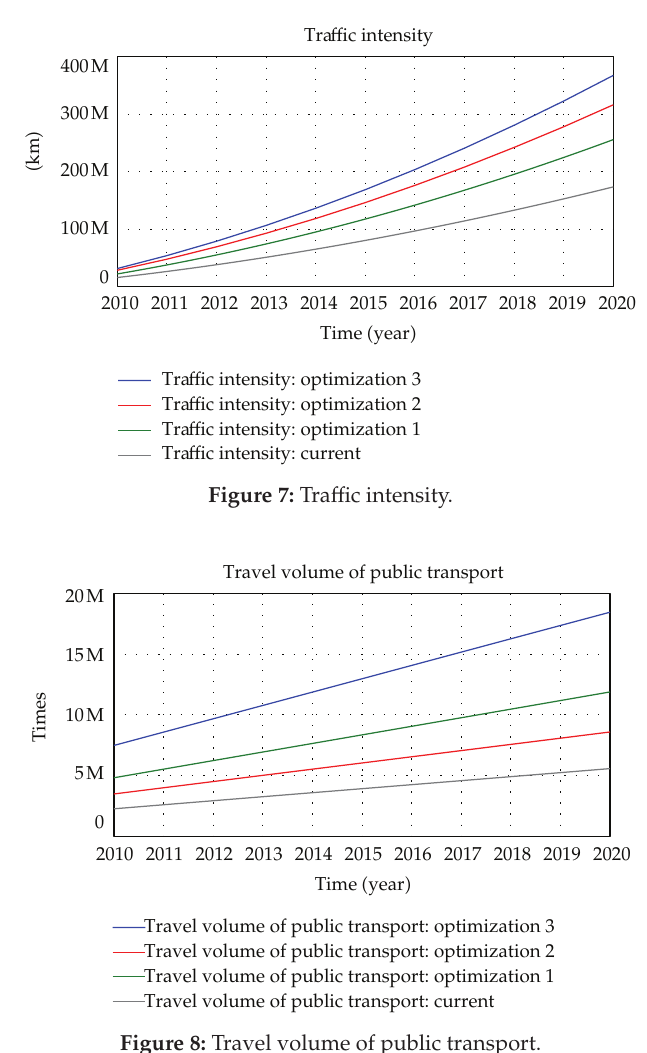
Figure 8: Travel volume of public